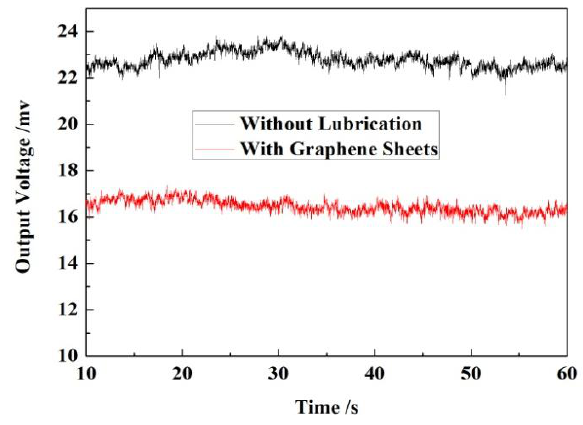
Figure 16. Curve obtained from the practical